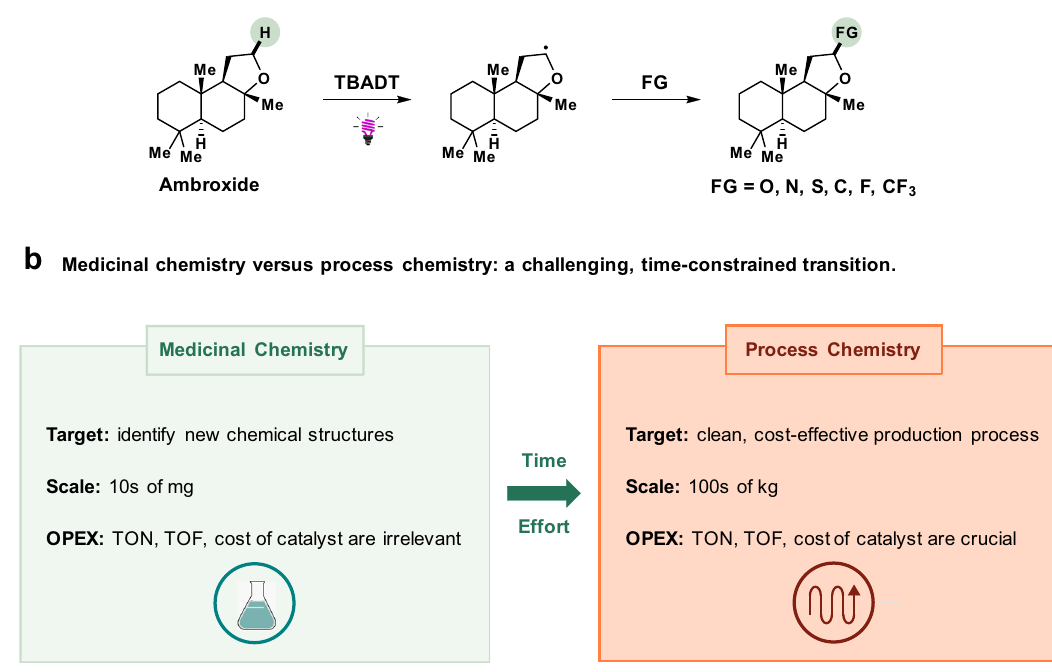
Photocatalytic Hydrogen Atom Transfer (HAT): a convenient strategy for C(sp 3 )–H functionalization.